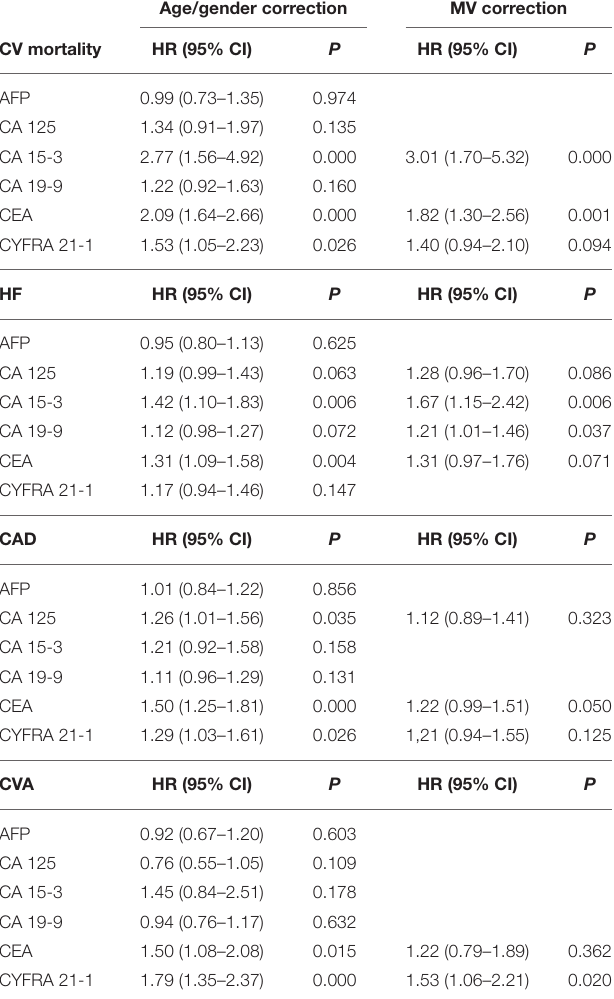
TABLE 6 | Correlation of tumour biomarker levels and CV mortality, HF, CAD, and CVA. Age/gender correction MV correction